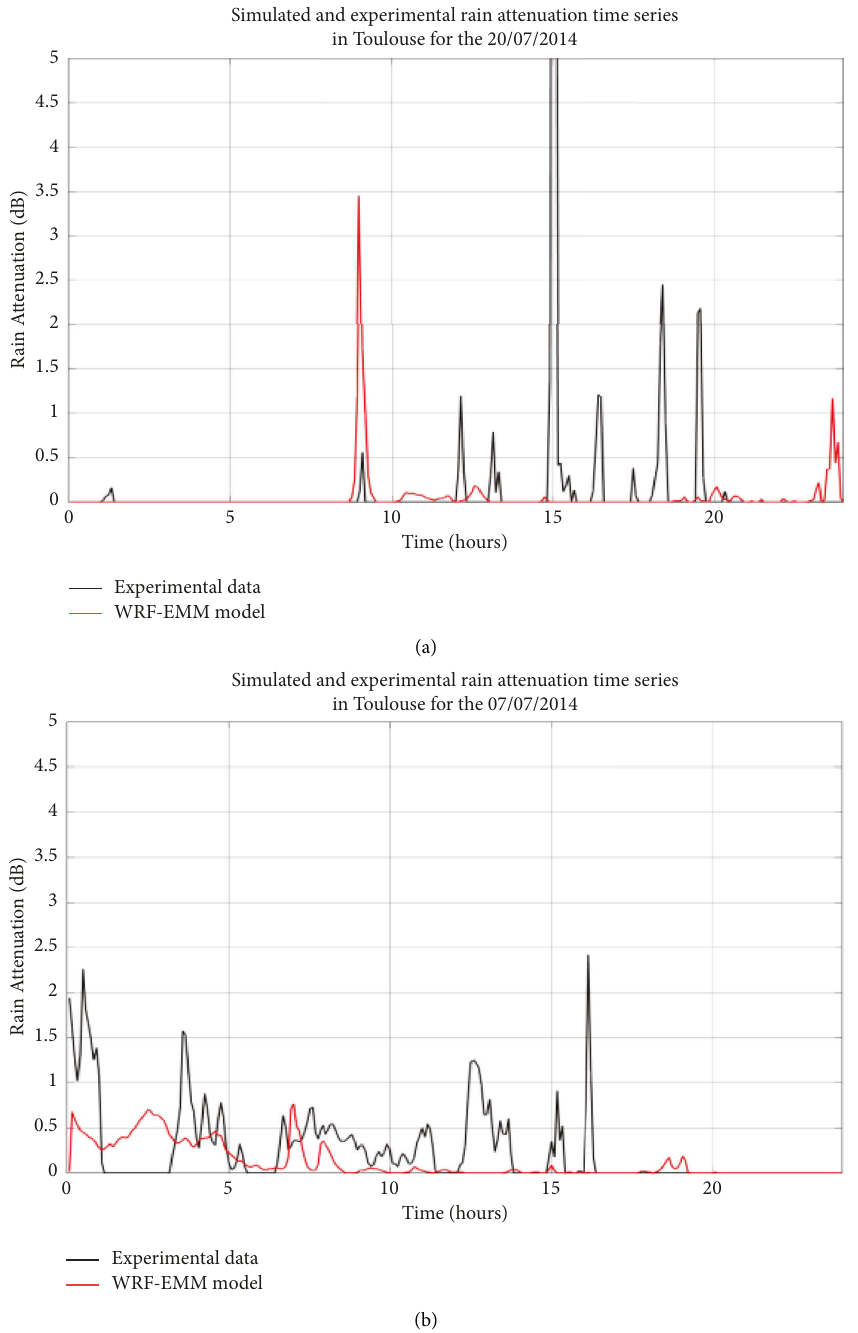
Figure 4: Examples of time series generated with WRF-EMM and measured in Toulouse from the 20.2 GHz beacon of ASTRA-3B on 20/07/ 2014 (a) and on 7/07/2014